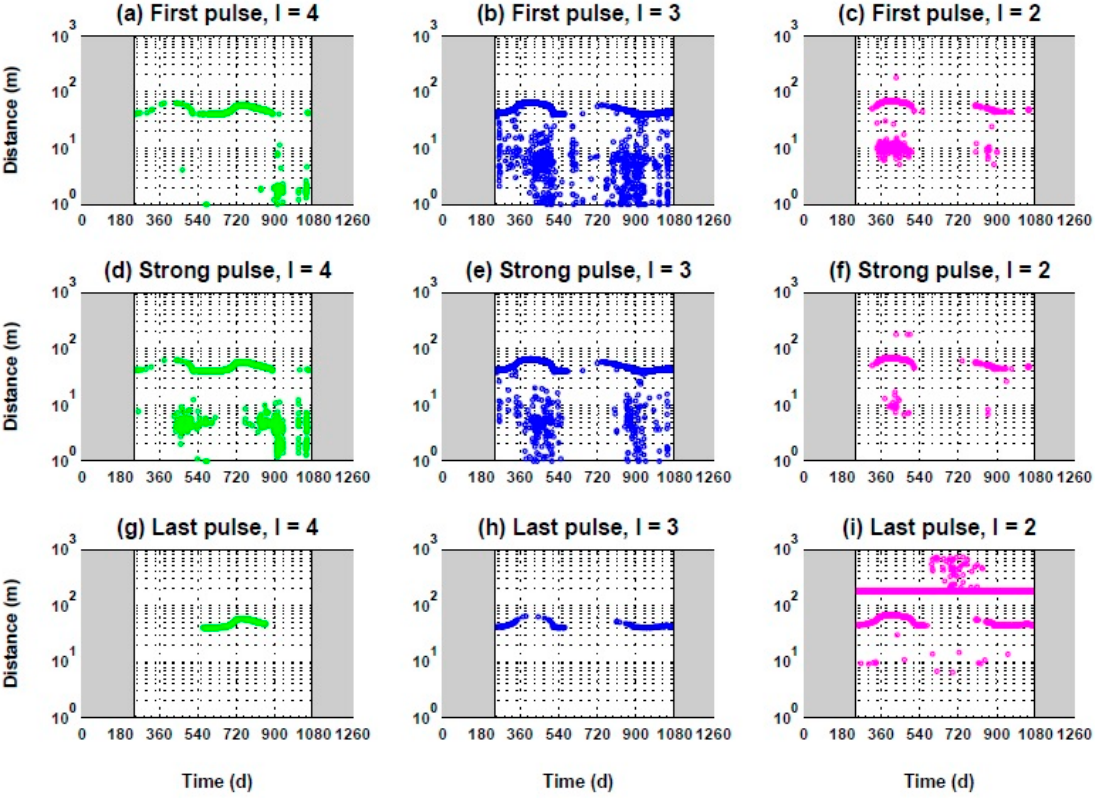
Figure 6. ( a–i ) Raw distance data measured by the test Lidar during the field experiment at the Cointzio reservoir. Each row corresponds to a different Lidar configuration (“first pulse”, “strongest pulse” or “last pulse”) and each column corresponds to a different intensity of the received signal ( I = 2, 3 or 4). Grey areas correspond to periods with a failure in the datalogging system.